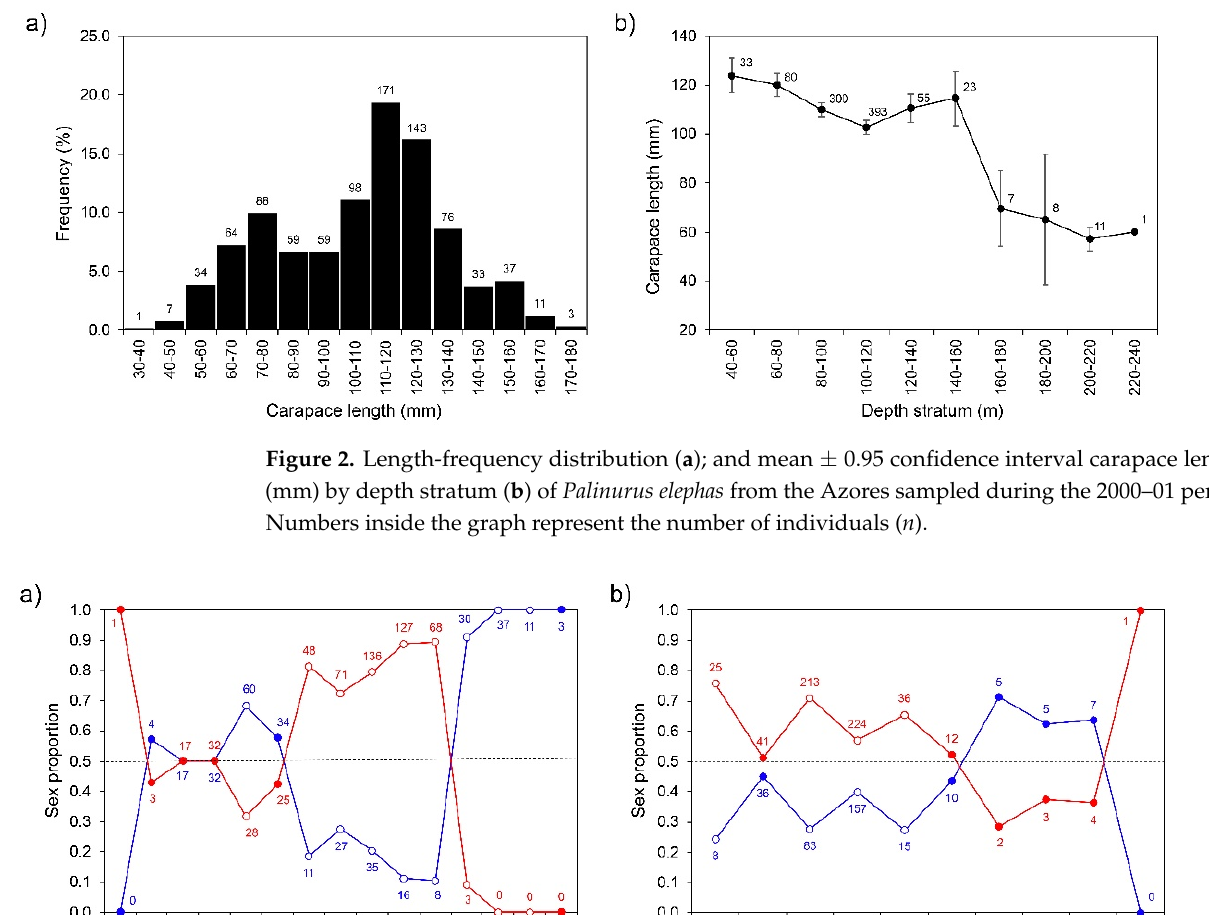
Figure 2. Length-frequency distribution ( a ); and mean ± 0.95 confidence interval carapace length (mm) by depth stratum ( b ) of Palinurus elephas from the Azores sampled during the 2000–01 pe- riod. Numbers inside the graph represent the number of individuals ( n ).